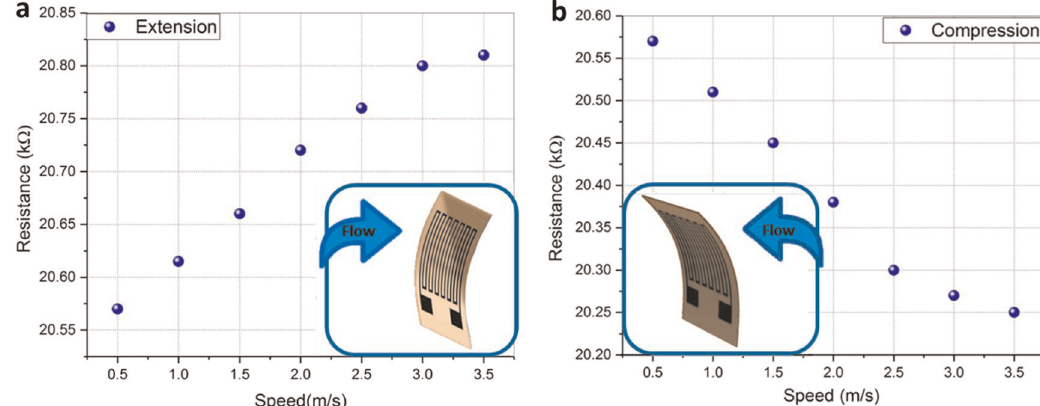
Fig. 5 The response of the bending sensor to different fl ow velocities, when the LIG electrode is a extended and b compressed